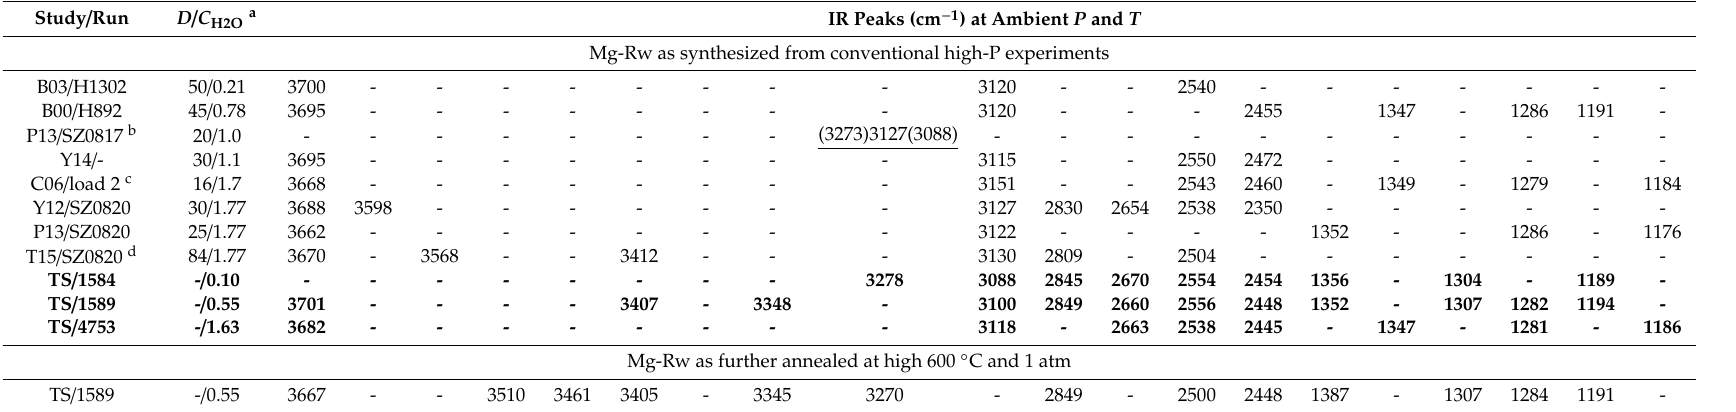
Table 3. IR peaks for water in Mg-Rw from di ff erent